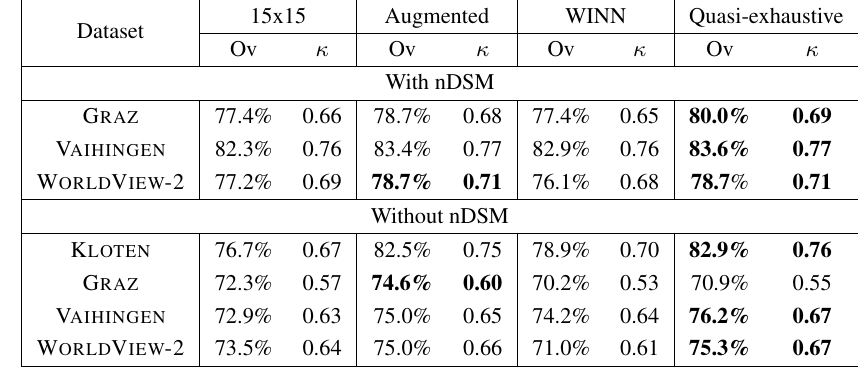
Figure 3: Original optical images used for evaluation